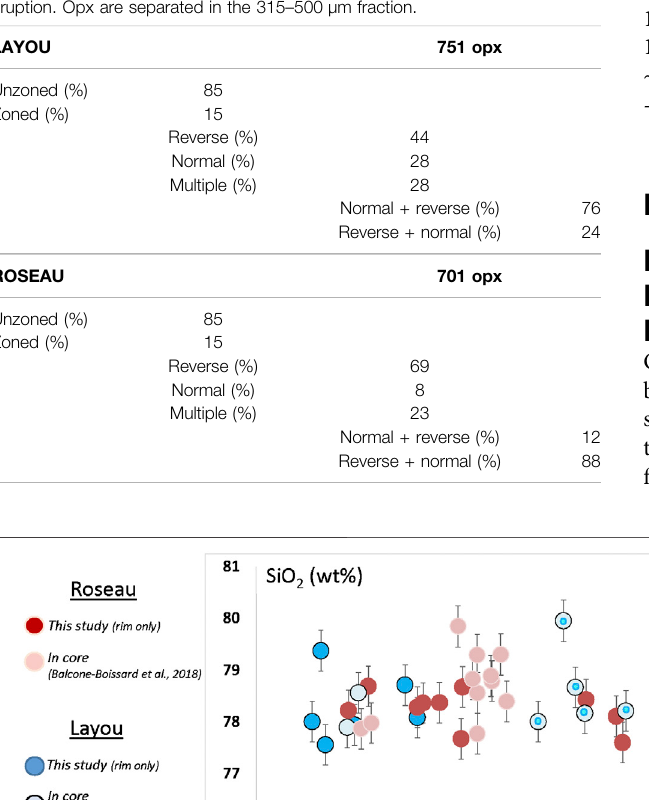
TABLE 1 | Statistic repartition of zonations in opx from Layou and Roseau eruption. Opx are separated in the 315 – 500 µm fraction.